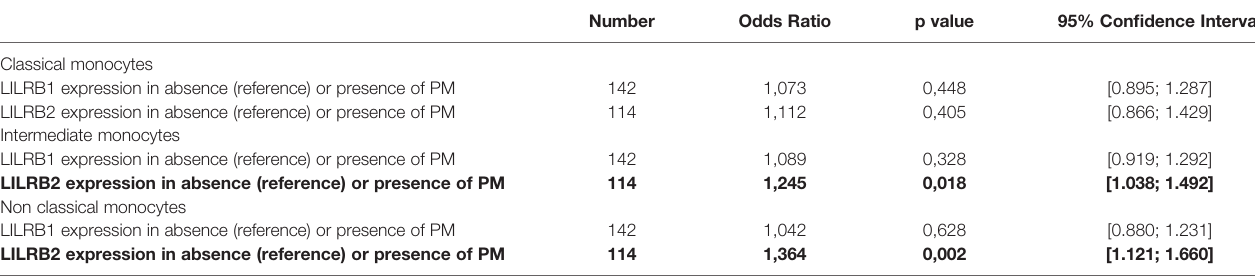
TABLE 3 | LILRB1 and LILRB2 expression on monocyte sub-populations in infants born to PM-mothers.